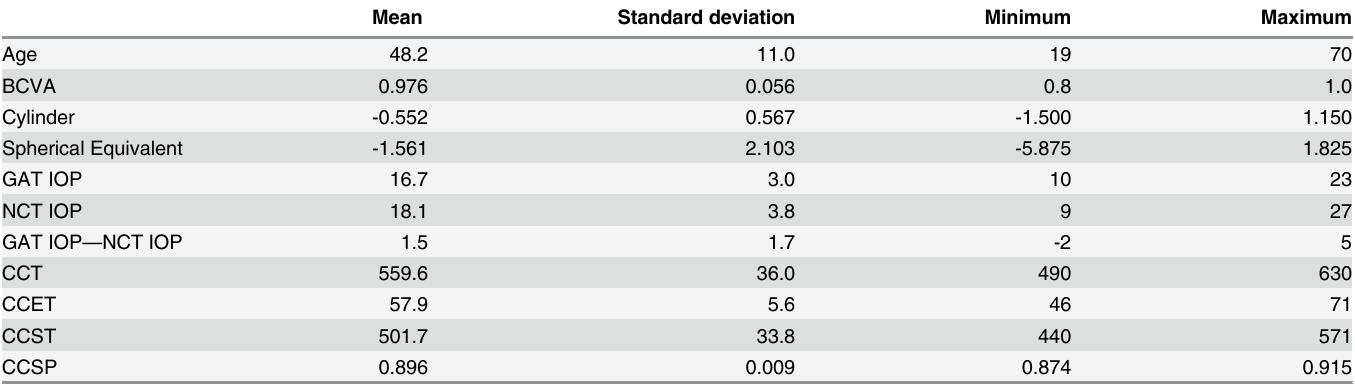
Table 1. Descriptive statics of involved